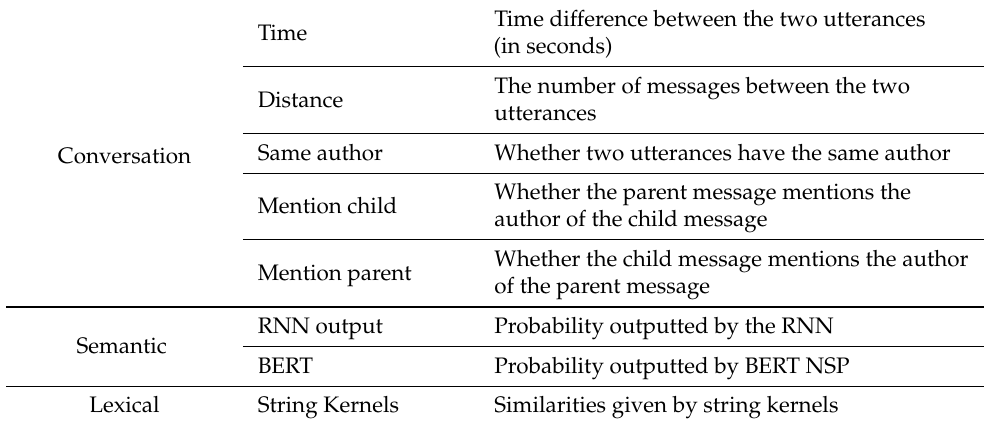
Table 3. Features used in the reply